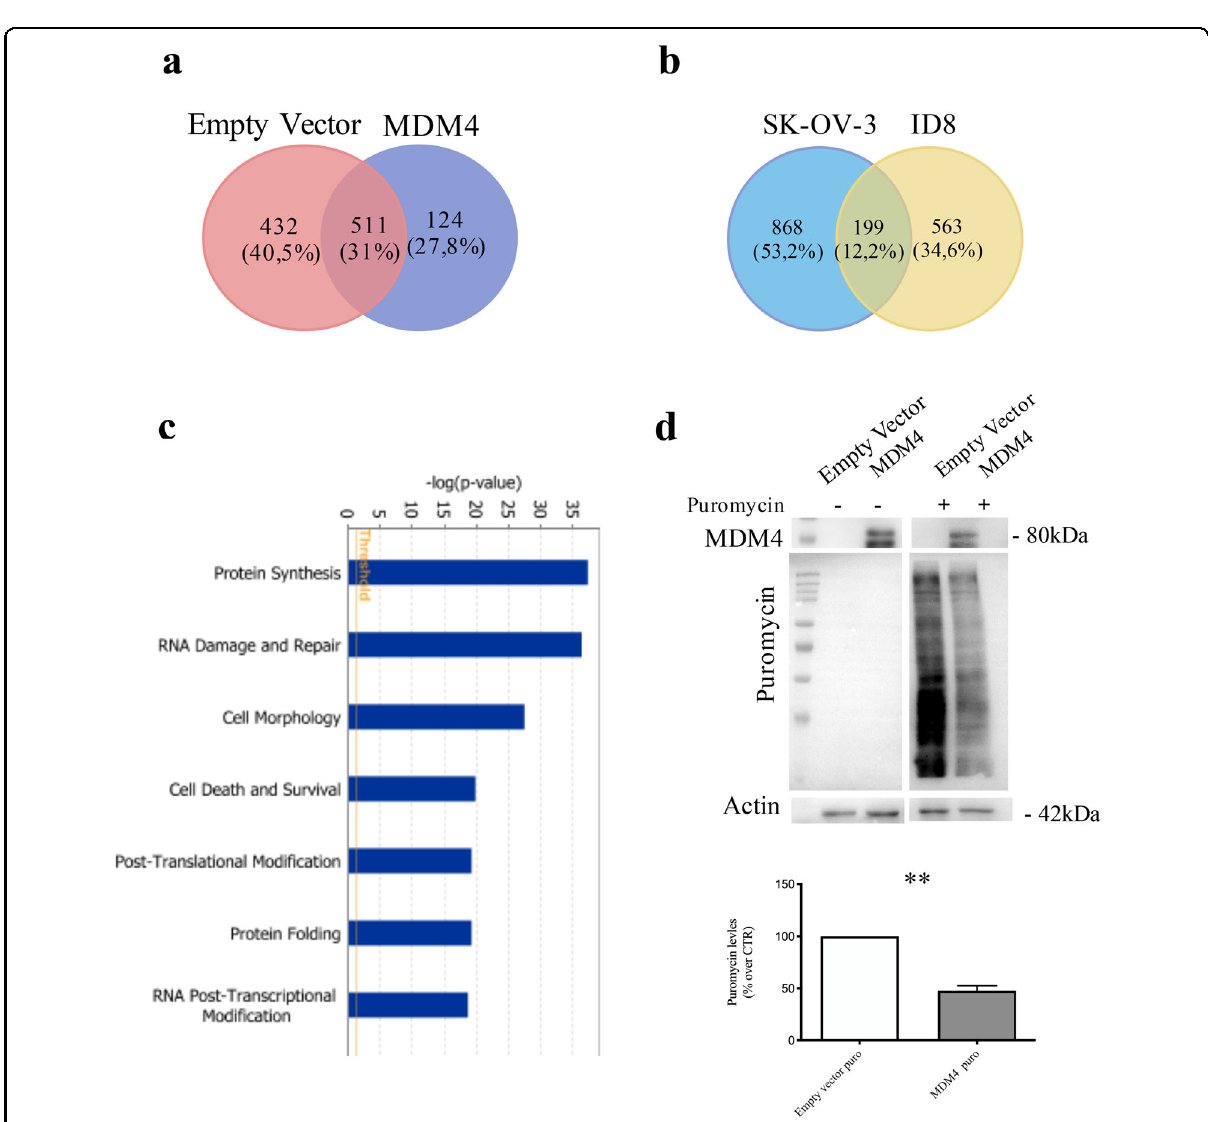
Fig. 4 MDM4 overexpression leads to a decreased generalized protein translation. a Venn diagram showing the overlap of protein expressed in Empty Vector- and MDM4-SK-OV-3 cells. b Venn diagram showing common proteins between SK-OV-3 and ID8 cells overexpressing MDM4. c IPA biofunctional analysis of the proteins differently expressed in MDM4-SK-OV-3 cells compared to Empty Vector. d SunSet assay of Empty Vector- and MDM4-SK-OV-3 cells; representative WB analysis of indicated proteins following indicated treatments (upper panel), quanti fi cation of three independent assays (lower panel) ( n = 3, one-sample t test p =